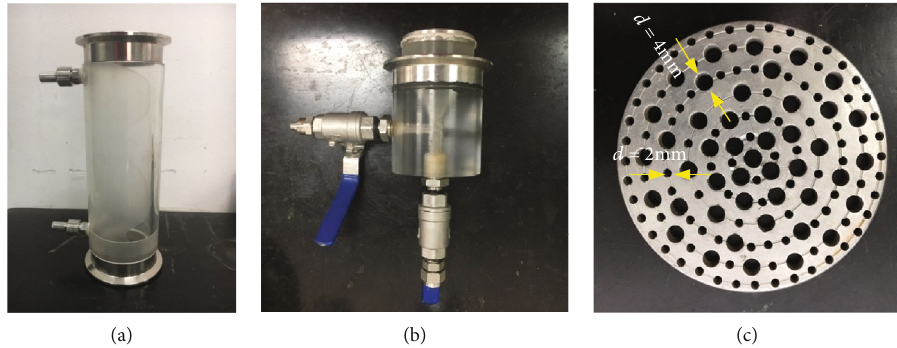
Figure 3: Components of the apparatus: (a) test tube, (b) cone-shaped joints, and (c) porous